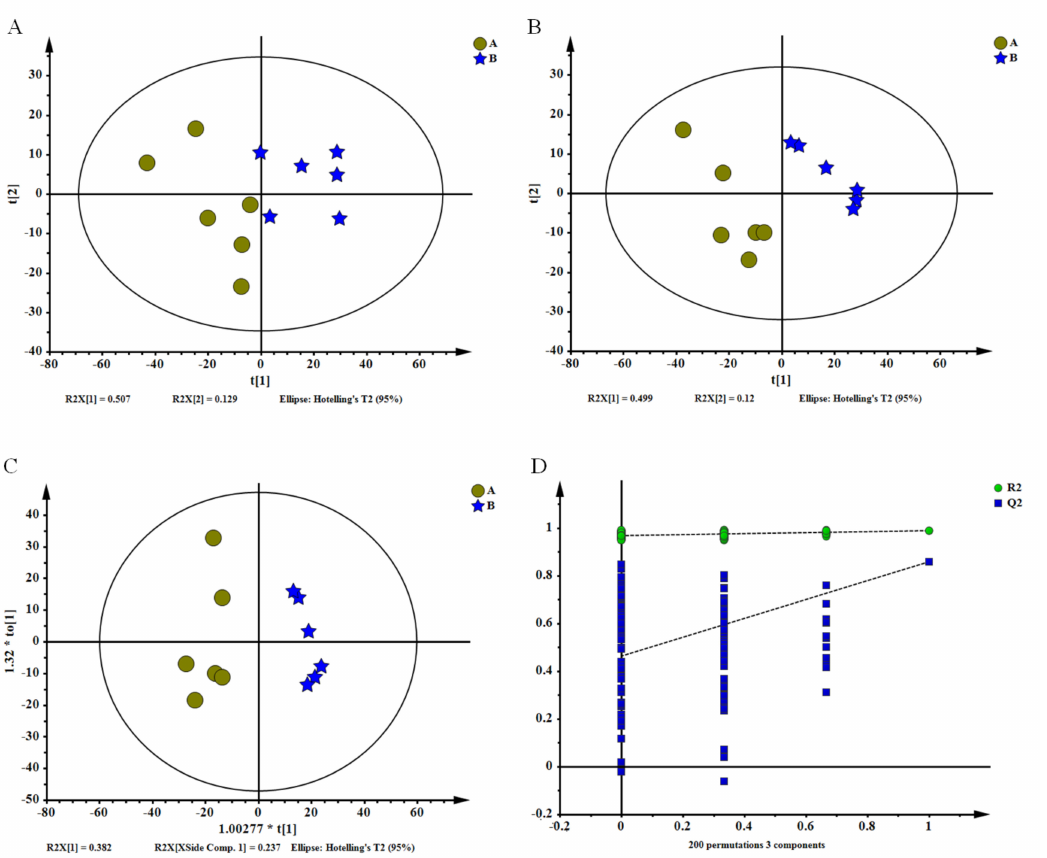
Figure 2. Group A, YAYT roasted for 13 min; Group B, YAYT roasted for 22 min. The vector value of R 2 (0.748) and Q 2 (0.668) from 200 permutations, which indicated that this model was not overfitting. Score plots from principal component analysis ( A ), partial least squares discrimination analysis ( B ), orthogonal partial least squares discrimination analysis ( C ), and its permutations test ( D ). The data set comprised 1037 filtered ion features. Spots in yellow indicate samples from 13 min treatment group, and stars in blue show samples from 22 min treatment